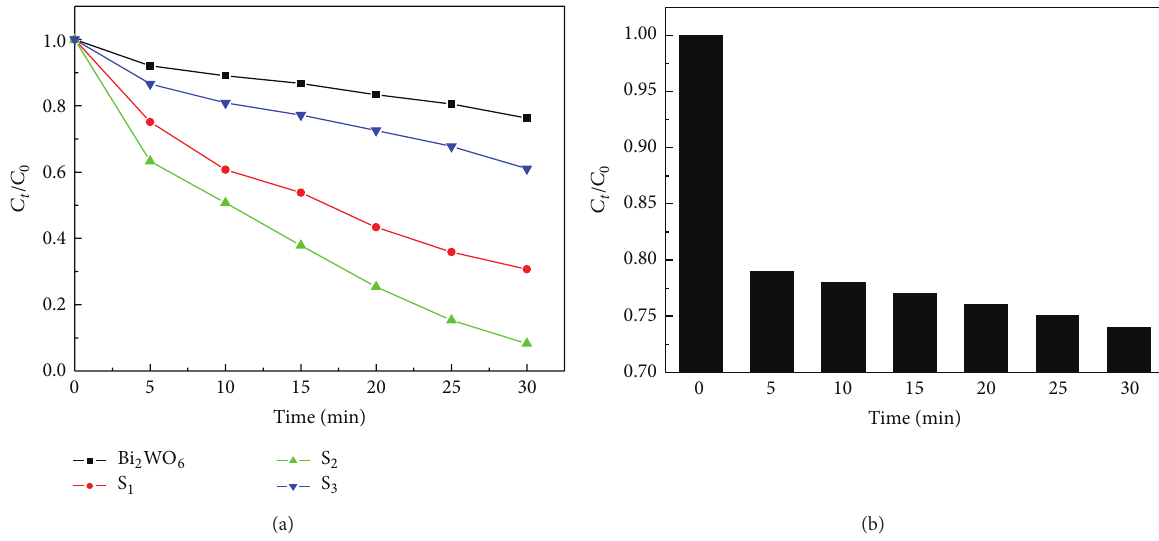
Figure 6: C 𝑡 /C 0 of the RhB concentration versus reaction time for (a) photocatalytic degradation with Bi 2 WO 6 , S 1 , S 2 , and S 3 under visible light and (b) adsorption with S 2